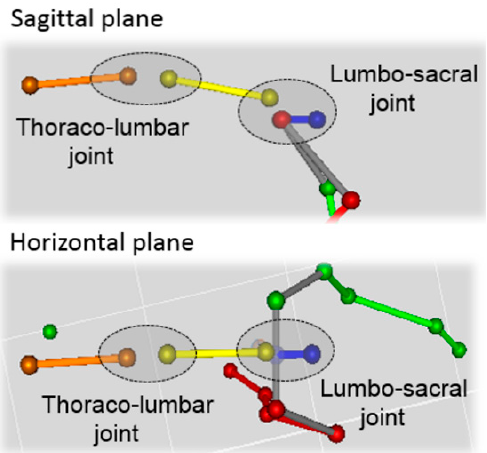
Figure 2. The locations of the thoraco-lumbar and lumbo-sacral joints in sagittal and horizontal